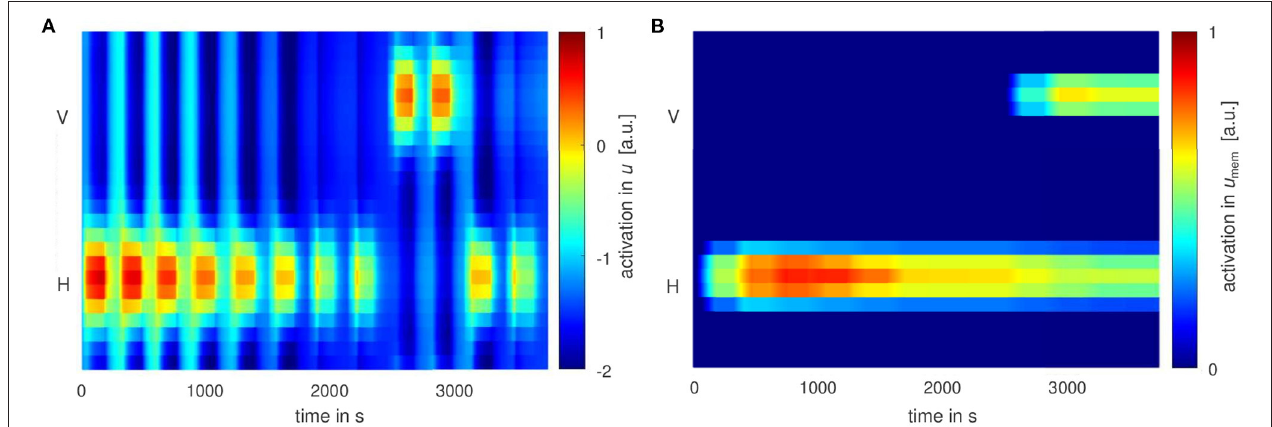
FIGURE 5 | (A) Evolution of activation in the intention field u . Supra-threshold activation (orange-red color) is caused by stimulus inputs applied to the respective field locations repeatedly. (B) Evolution of the corresponding memory trace u mem . The memory trace grows at supra-threshold field locations while it decays at all other